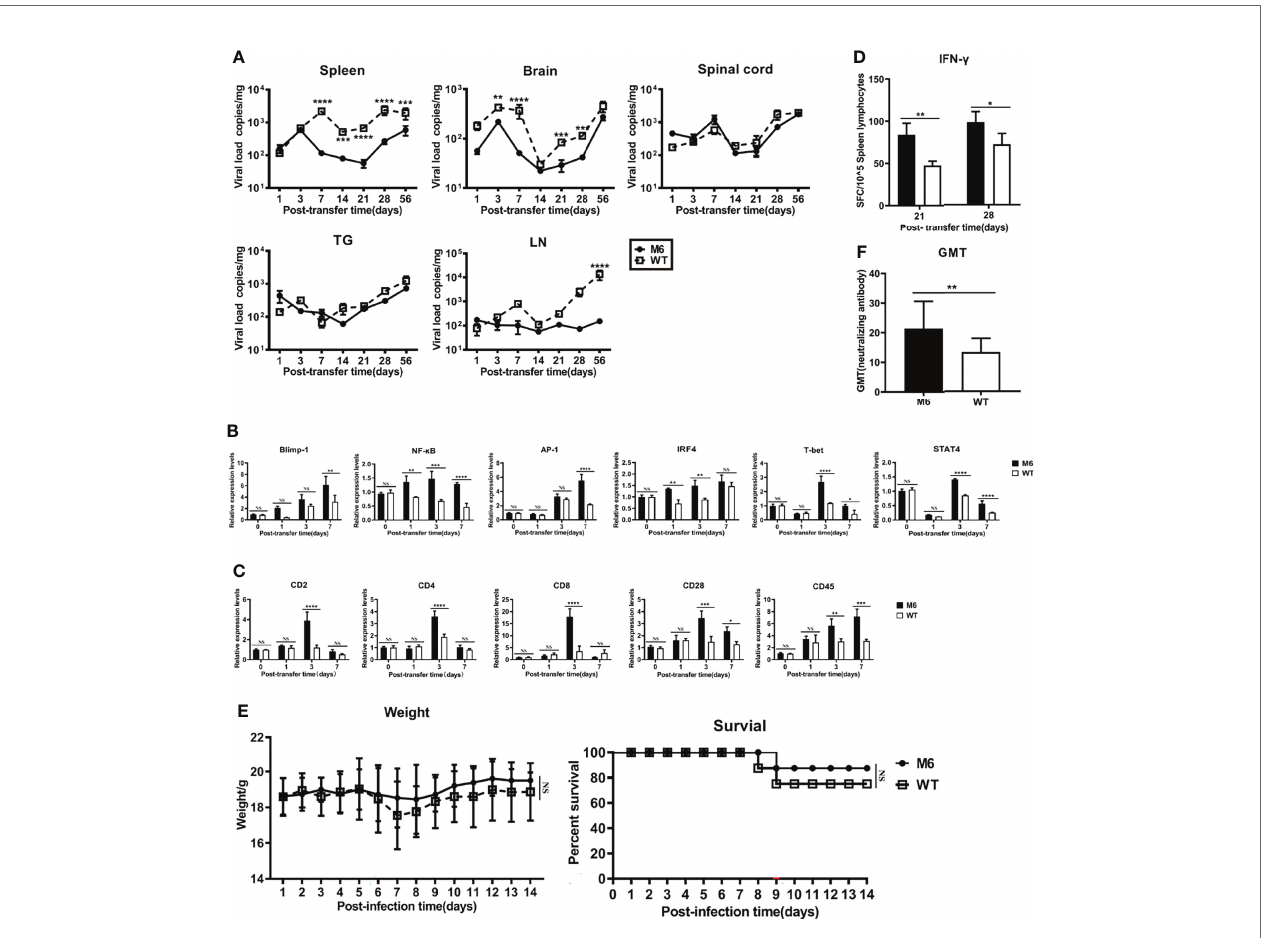
FIGURE 6 | Dendritic cells carrying HSV-1 antigen were adoptively transferred into mice. (A) As determined by RT-qPCR, viral load in the spleen, brain, spinal cord, trigeminal ganglion, and inguinal lymph node after DCs carrying M6 (circle) and WT (square) antigens transferred into mice. (B) The expression levels of genes associated with T-cell activation in inguinal lymph node tissue after transferring dendritic cells infected with WT (white square) and M6 (black square) compared with the control group (transferring uninfected DCs). Detection of the p105 subunit to represent the level of NF- k B and detection of the c-Jun subunit to represent the level of AP-1. The results are normalized by the endogenous GAPDH expression level. The expression levels were calculated using the comparative Ct ( DD Ct) method by relative quanti fi cation. (C) The expression levels of genes associated with surface marker molecules after T cell activation in lymph node tissue after transferring dendritic cells infected with WT (white square) and M6 (black square) compared with the control group. The results are normalized by the endogenous GAPDH expression level. The expression levels were calculated using the comparative Ct ( DD Ct) method by relative quanti fi cation. (D) The ELISpot responses show IFN- g -secreting T cells among splenic lymphocytes after transferring dendritic cells carrying M6 (black square) and WT (white square) antigens. (E) Bodyweight and survival rate of mice subjected to transfer of dendritic cells carrying M6 (circle) and WT (square) antigens followed by wild-type challenge. (F) The titer of neutralizing antibody against HSV-1in transferred-DCs mice after being challenged with the wild-type strain. The samples were obtained at 28 dpi. The data are shown as the mean ± SEM based on data from three independent experiments. * P < 0.05, ** P < 0.01, *** P < 0.001, **** P < 0.0001. NS, no signi fi